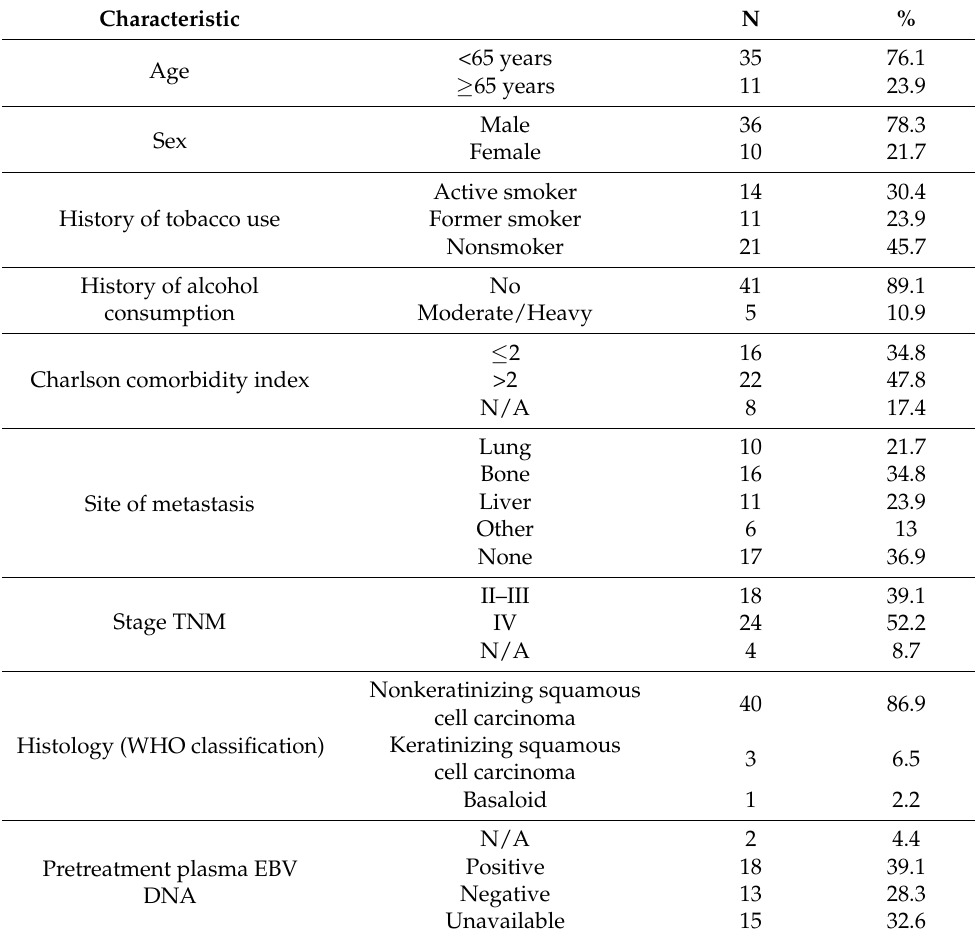
Table 1. Baseline patient characteristics. Abbrev. EBV = Ebstein–Barr Virus, N/A: Not Available, TNM = Tumor Node Metastasis, WHO = World Health